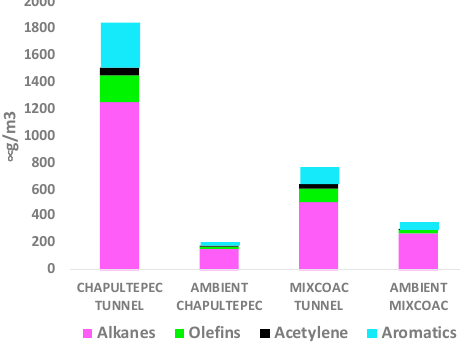
Figure 2. Concentration of the organic groups in the tunnels and ambient air.